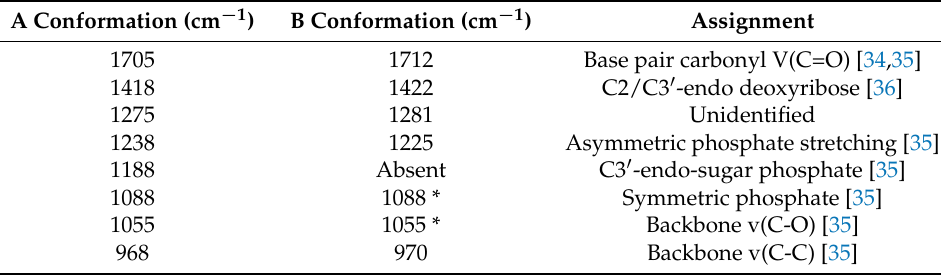
Figure 3. Figure 3 . Infrared (IR) raw spectra ( left ) and 2nd derivative ( right ) of compounds PFB (1), TMB (2) and cisplatin. Table 1. Peak positions for DNA conformational